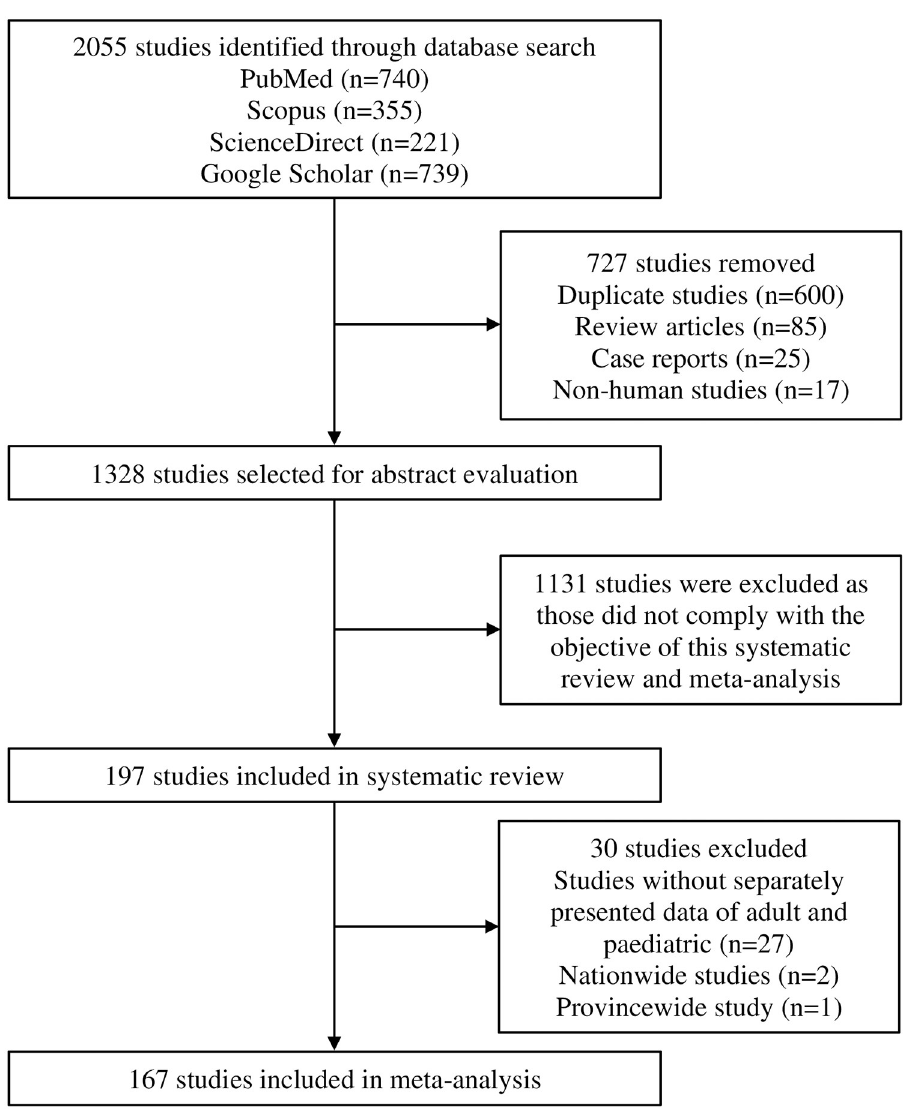
Fig 1. PRISMA flow diagram of study